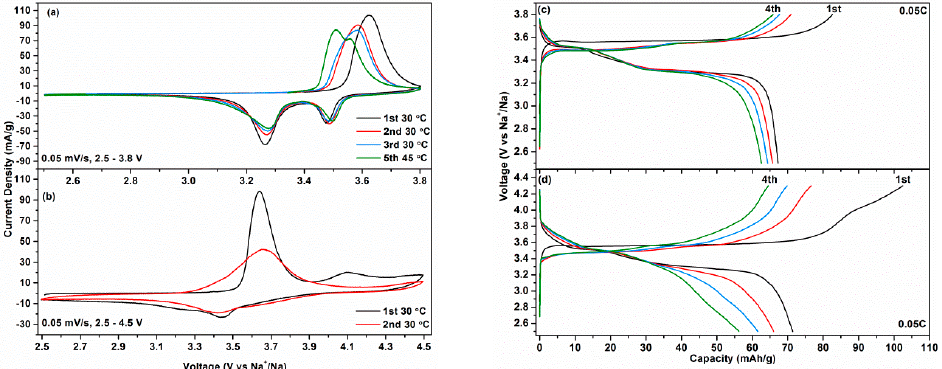
Figure 4. Cyclic voltammetry (CV) ( a , b ) and charge / discharge ( c , d ) curves of the Na 3 V(PO 4 ) 2 cathode.